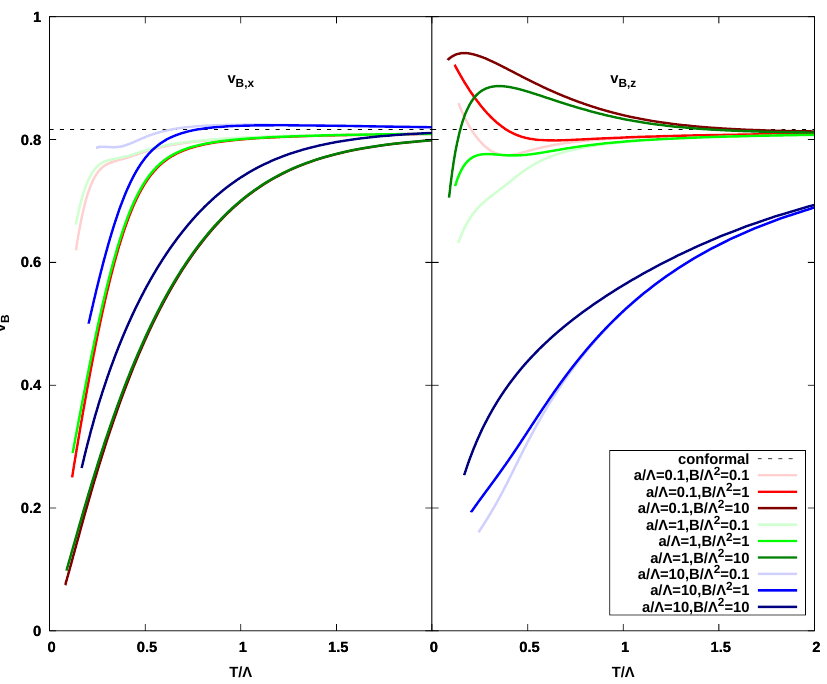
Figure 10 . Components of the butterfly velocity as a function of temperature (in units of Λ ∼ 1 GeV) for the parallel configuration. For all the plots we have fixed c = 0 . 25 , but in this case both the magnetic field B and the anisotropic deformation are introduced along the z -direction. The component v z is also enhanced in the IR and exceeds the bound found in [27], although it is slightly B smaller than in the perpendicular case. This is due to a constructive effect between a and B